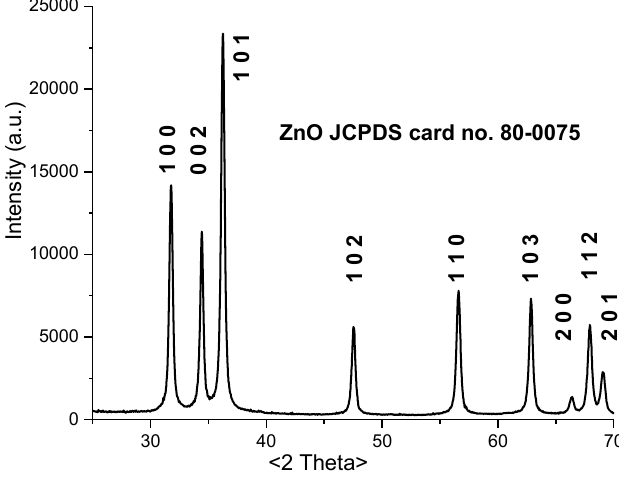
Figure 3. X-ray di ff raction pattern for the ZnO Figure 3. X-ray diffraction pattern for the ZnO nanoparticles.